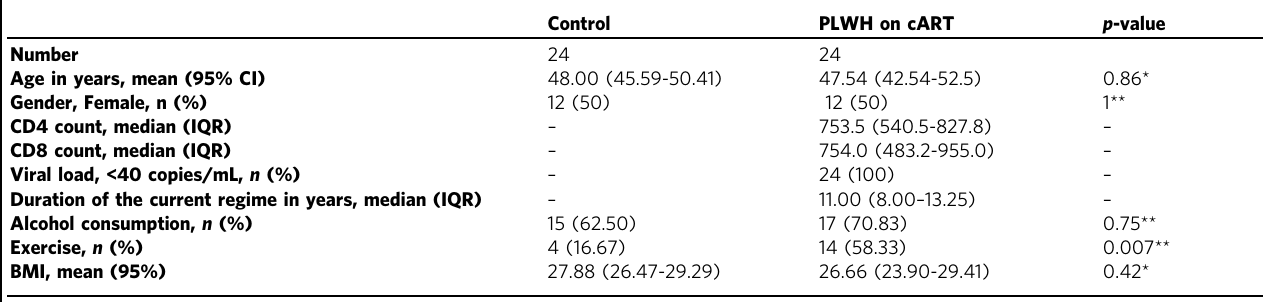
Table 1 Clinical and demographic